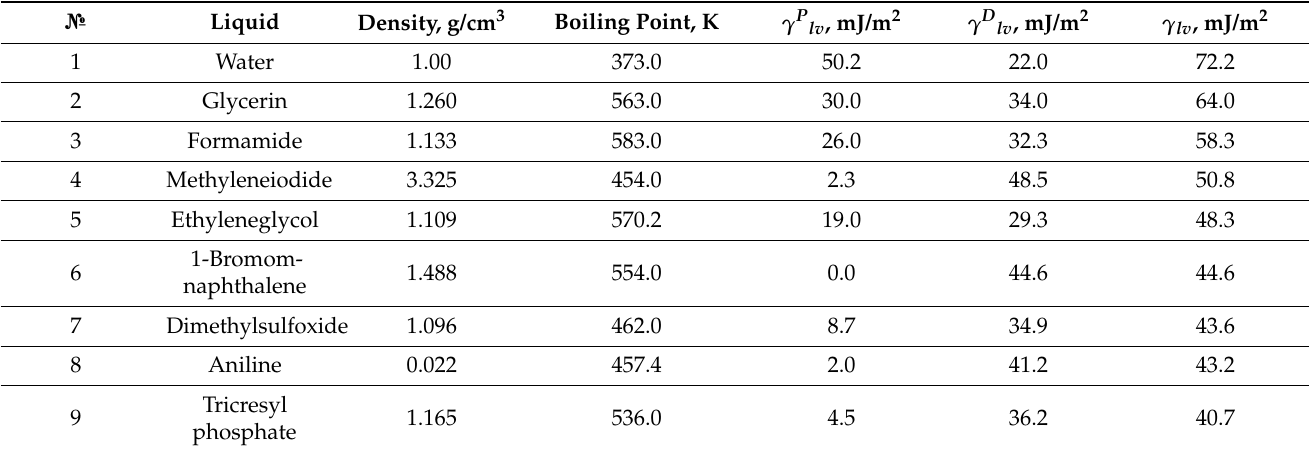
Table 2. Characteristics of the test